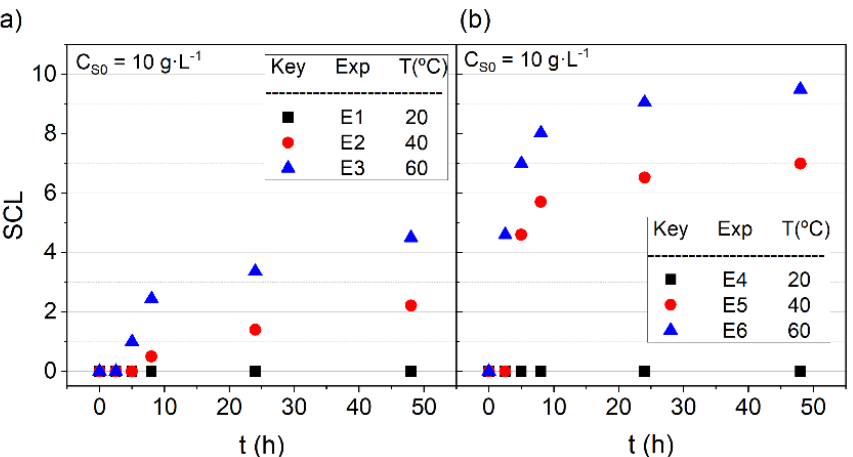
Figure 2. SCL profiles with time. C So = 10 g · L − 1 , temperature = (20, 40 and 60) ◦ C ( a ) absence of SVCOCs; ( b ) presence of SVCOCs.